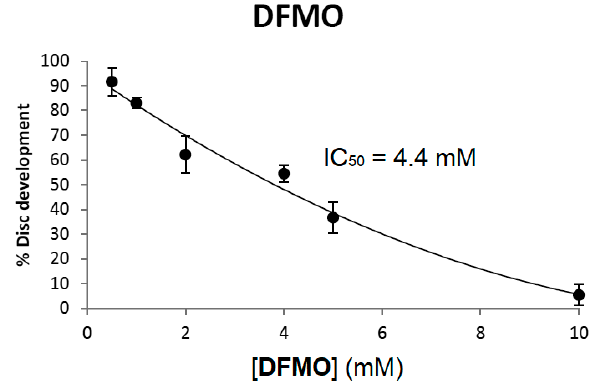
Figure 5. DFMO inhibits imaginal disc development. DFMO ( 4 ) was tested at different concentrations and the percentage of disc development was determined for each concentration after 18 h of incubation. All data points were repeated at least in triplicate and error bars reflect the standard error of the mean (SEM). The IC 50 value corresponds to the concentration of DFMO needed to inhibit 50% of discs from developing into rudimentary legs.